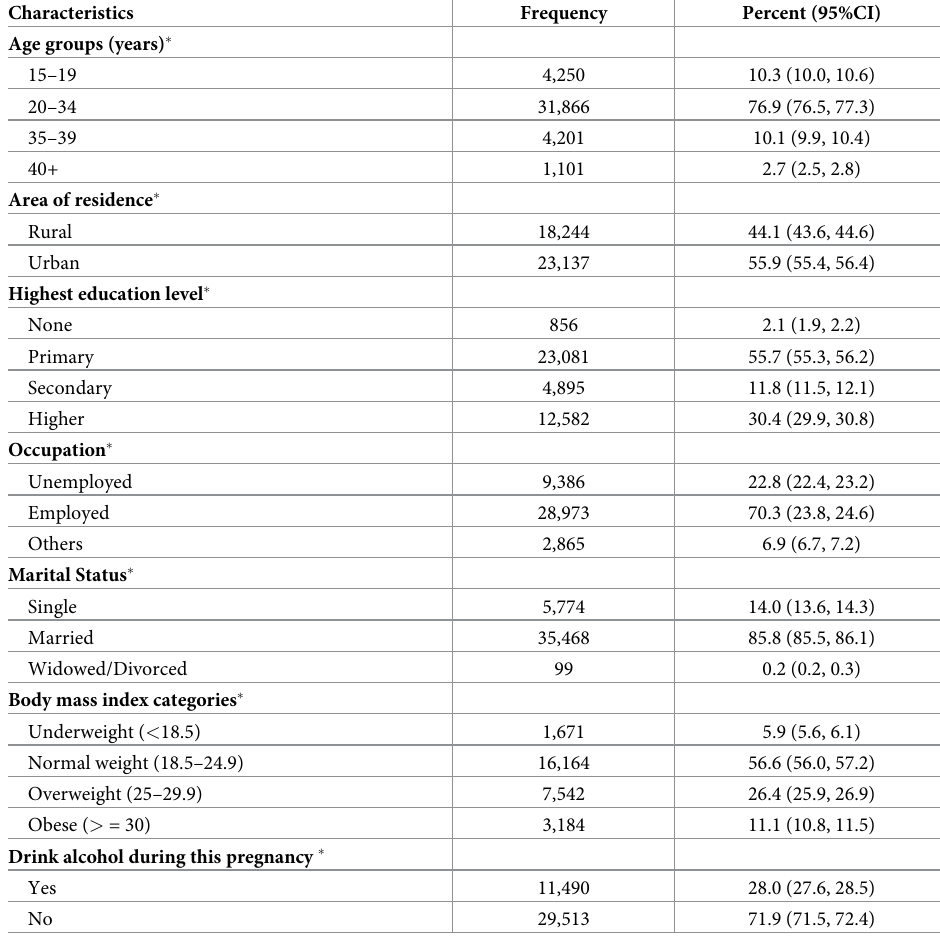
Table 1. Maternal background characteristics at first birth (N =